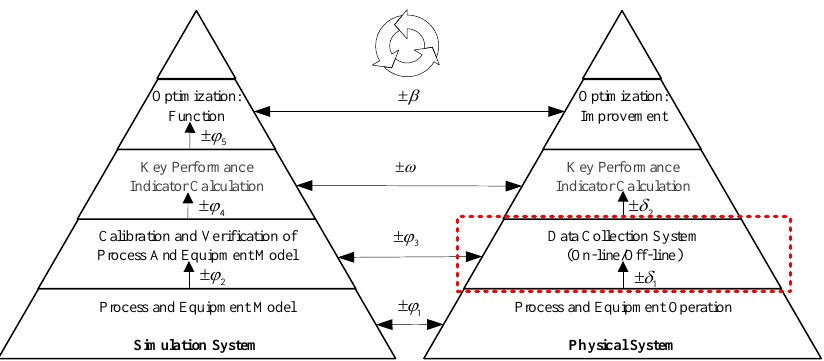
Figure 1. Error propagation model for the implementation of the optimization functionality in crushing plants [1,9] .